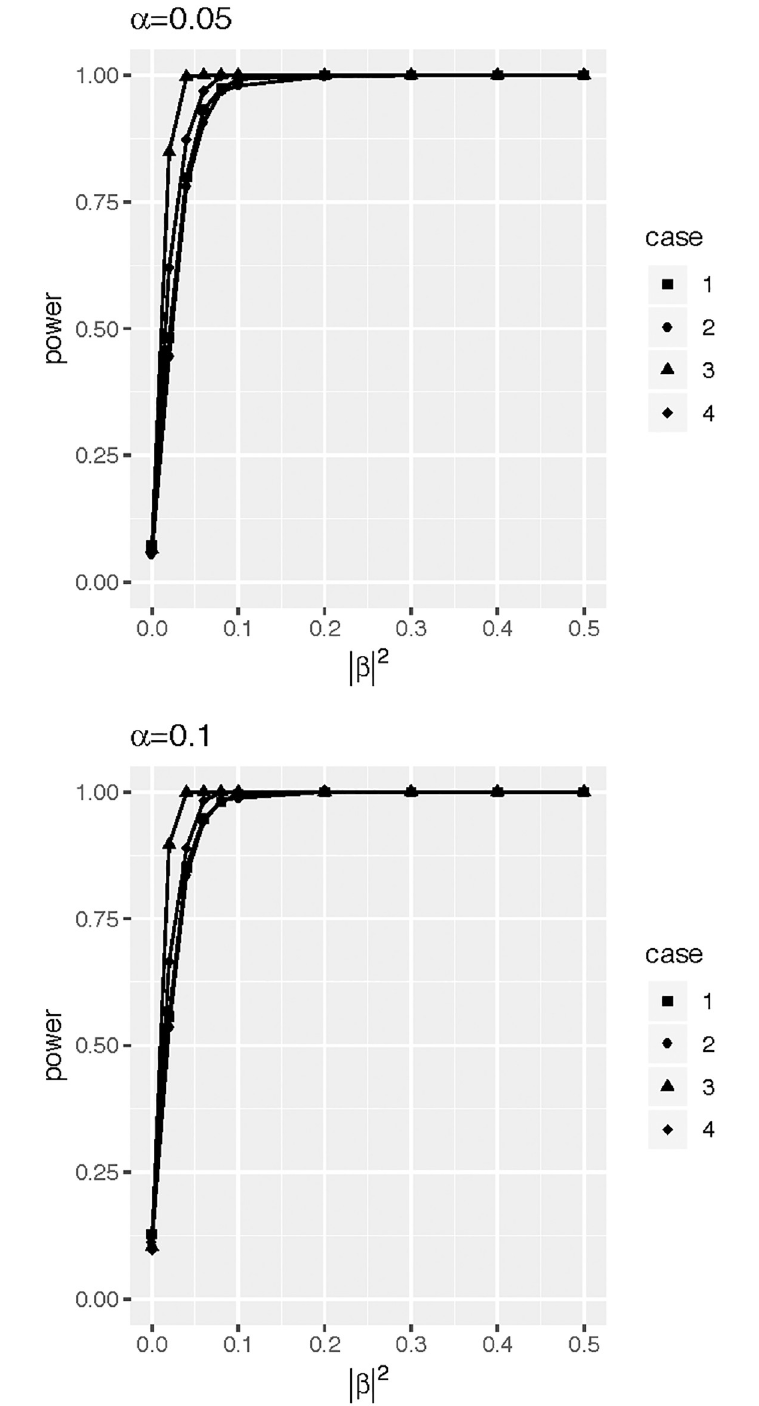
Fig 3. Power curves of the FLUTE method. Case 1: K = L = 5 and n = 40; Case 2: K = L = 11 and n = 40; Case 3: K = L = 5 and n = 100; Case 4: K = L = 11 and n = 100. The left figure is for α = 0.05, and the right is for α = 0.1.